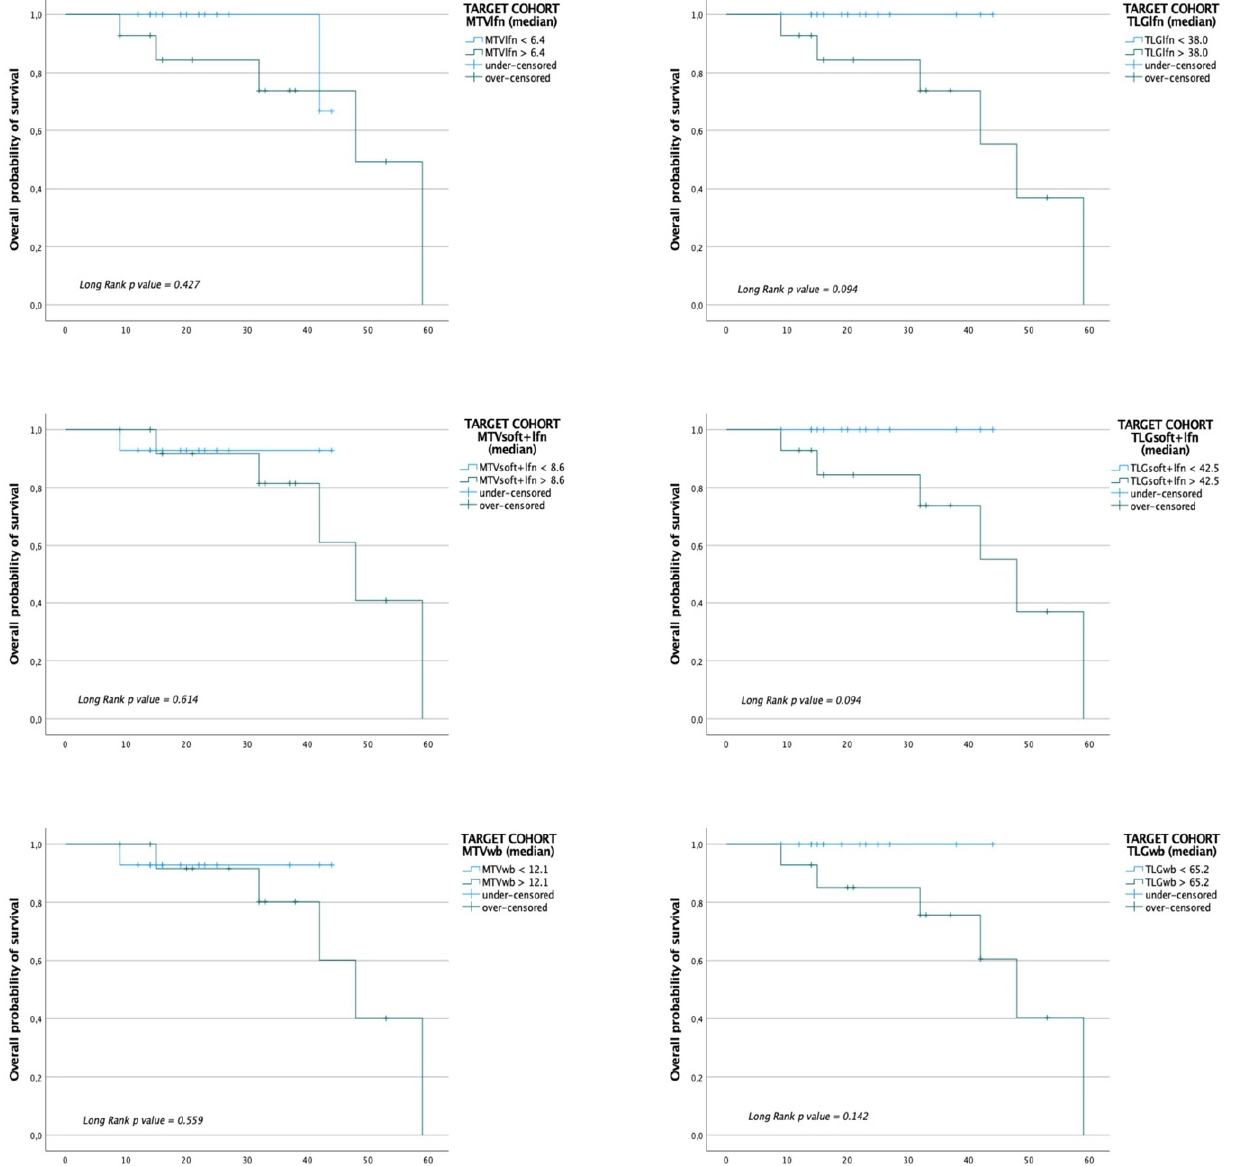
Figure 4. Kaplan–Meier plot analysis for whole-body and district MTV and TLG with overall survival (OS) in the target cohort. Population was grouped by the median value.